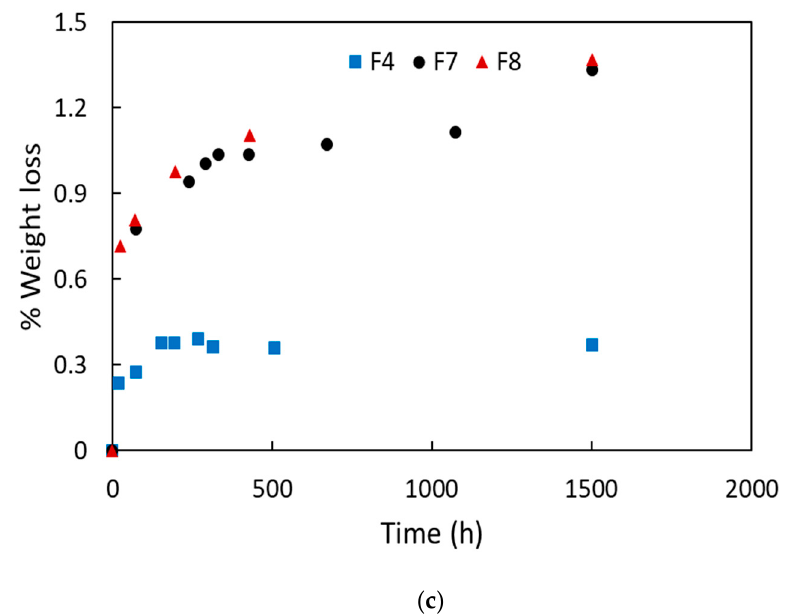
Figure 3. Weight loss percentage as function of the time for (a) F1, F2, F3 and F4 formulations, (b) F4 compared to F5, F6, (c) F4 compared to F7 and F8.